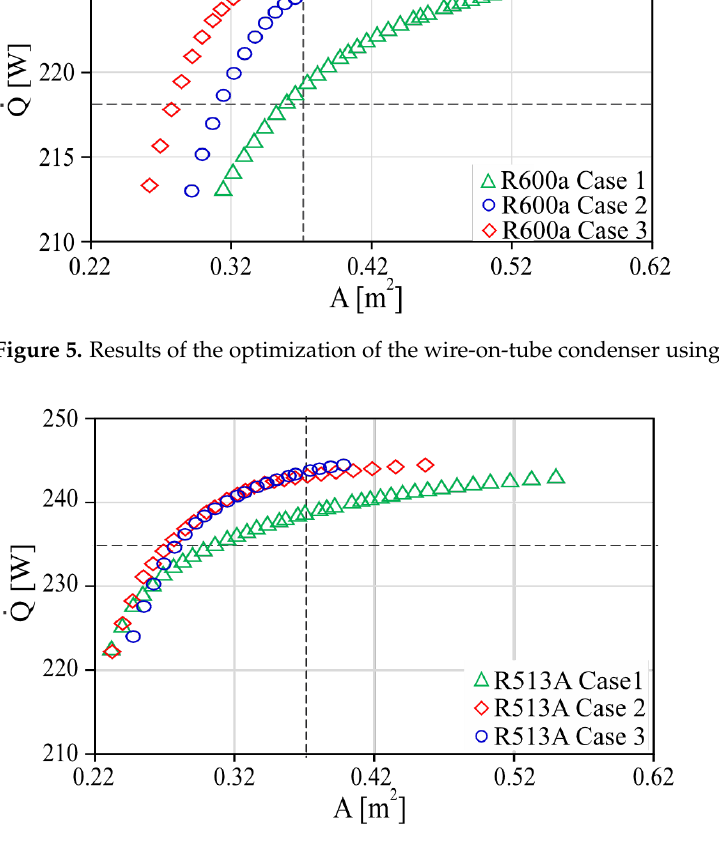
Figure 6. Results of the optimization of the wire-on-tube condenser using